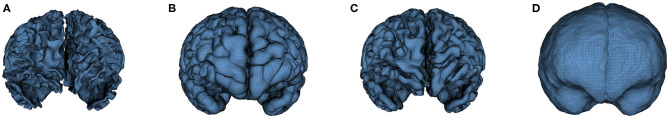
An example of the cortical surfaces reconstructed from the input infant structural MRI. (A) WM Surface, (B) GM Surface, (C) Middle Surface, and (D) CSF Hull Surface.